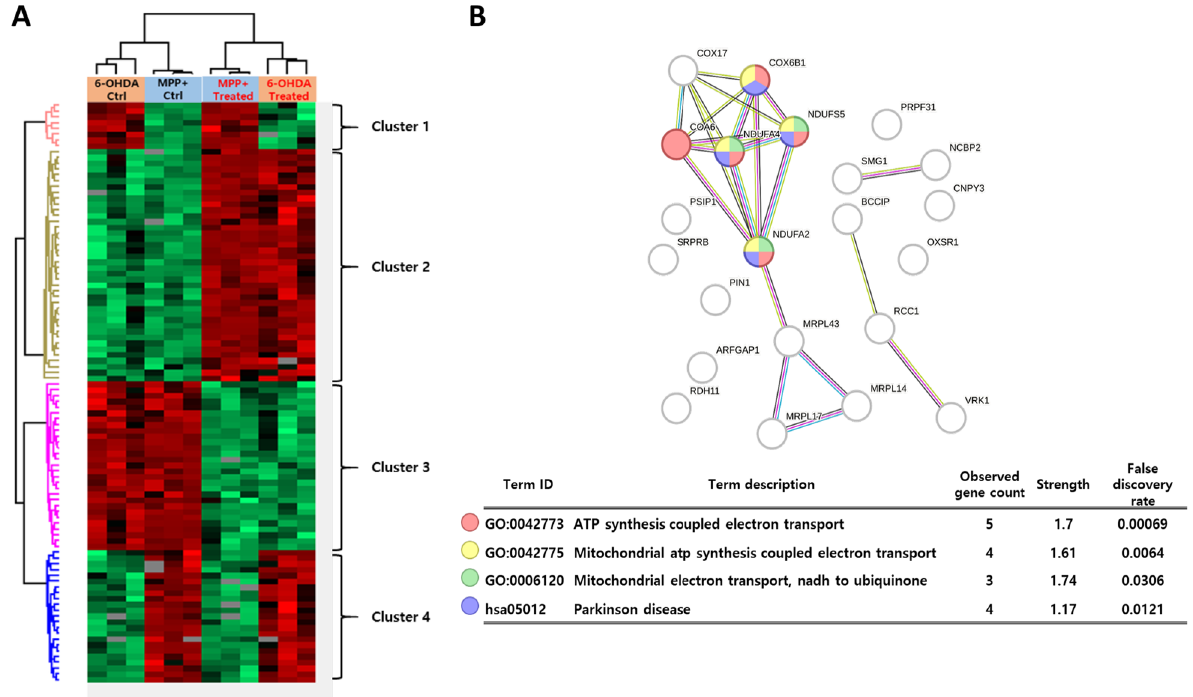
Fig. 4. 6‑OHDA and MPP reversibly altered the expression of electron transport proteins associated with mitochondrial dysfunction in SH‑SY5Y + cells. A Heatmap analysis of four conditions (6‑OHDA control group, 6‑OHDA treatment, MPP control group, and MPP treatment) for 100 + + proteins with p < 0.05 and fold change > 1.5 in 6‑OHDA and MPP ‑treated SH‑SY5Y cells shows clusters enriched in each proteome set. B STRING + protein–protein interaction analysis for 23 proteins represented by cluster 4 upregulated by 6‑OHDA and downregulated by MPP . 6-OHDA + 6‑hydroxydopamine, MPP +